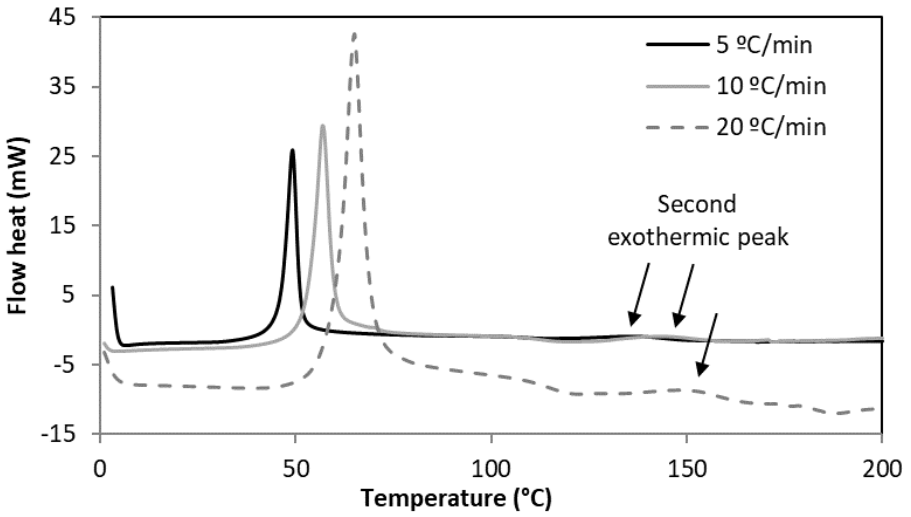
Figure1. DSCthermogramforthecontrolbonecementsampleswhensubjectedtodi ff erentheatingrates. Figure 1. DSC thermogram for the control bone cement samples when subjected to different heating rates.